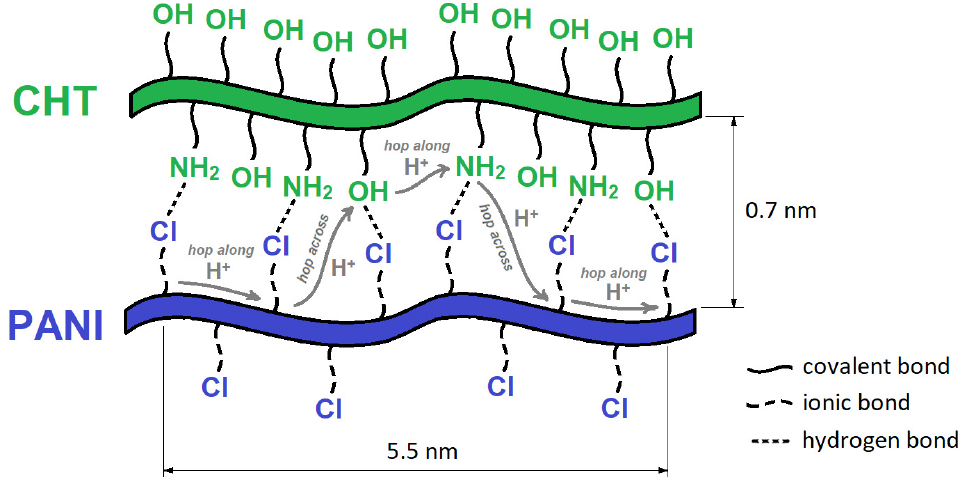
Figure 9. Illustrative view of the proton-hopping mechanism in PANI/CHT composites. The estimated dimensions of PANI/CHT chains are based on the covalent radii of the atoms.